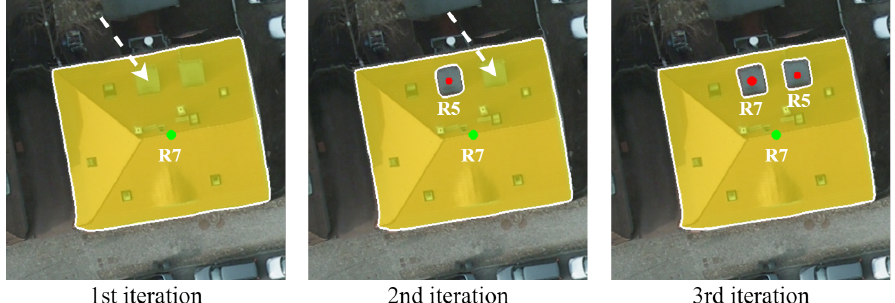
Figure 5. Visualization of the automatic update of the radii. “R7” means that the click is encoded with a radius of 7 pixels. The green and red points stand for positive and negative clicks, respectively. The radius is fixed to the mid-value when keying and will be updated in the next iteration. So, the radius of the negative click is 5 pixels in the 2nd iteration and is updated to 7 pixels in the 3rd iteration.